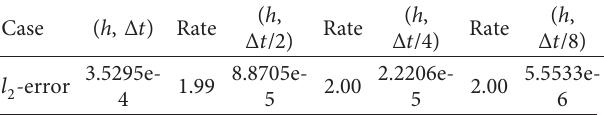
Table 3: Convergence test results of the CN method for time step.